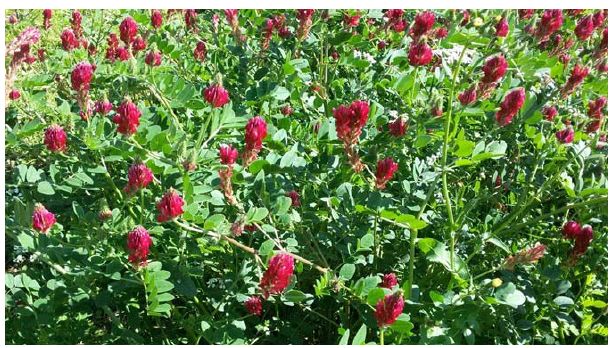
Figure 3. Sulla coronaria SC004 at flowering stage.